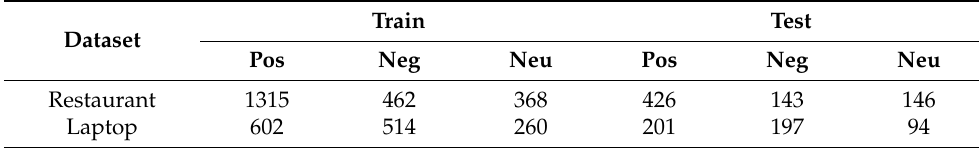
Table 1. Restaurant and Laptop dataset details.